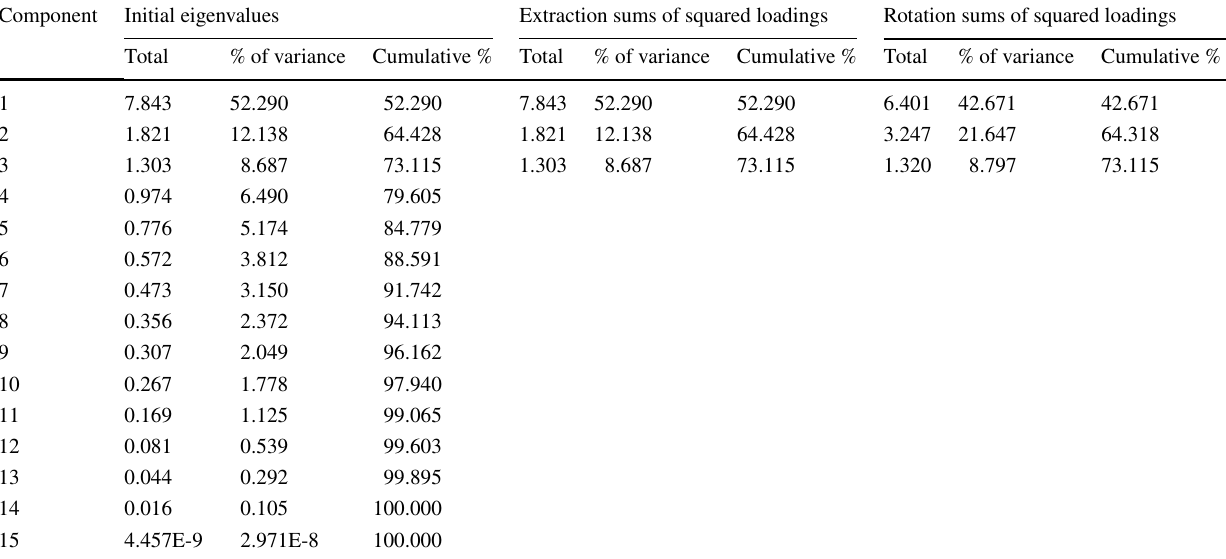
Table 4 Total variance explained